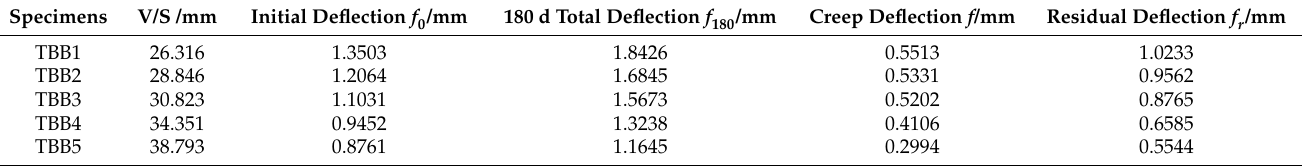
Table 9. Initial deflection, 180 d total deflection, creep deflection and residual deflection of the beams.